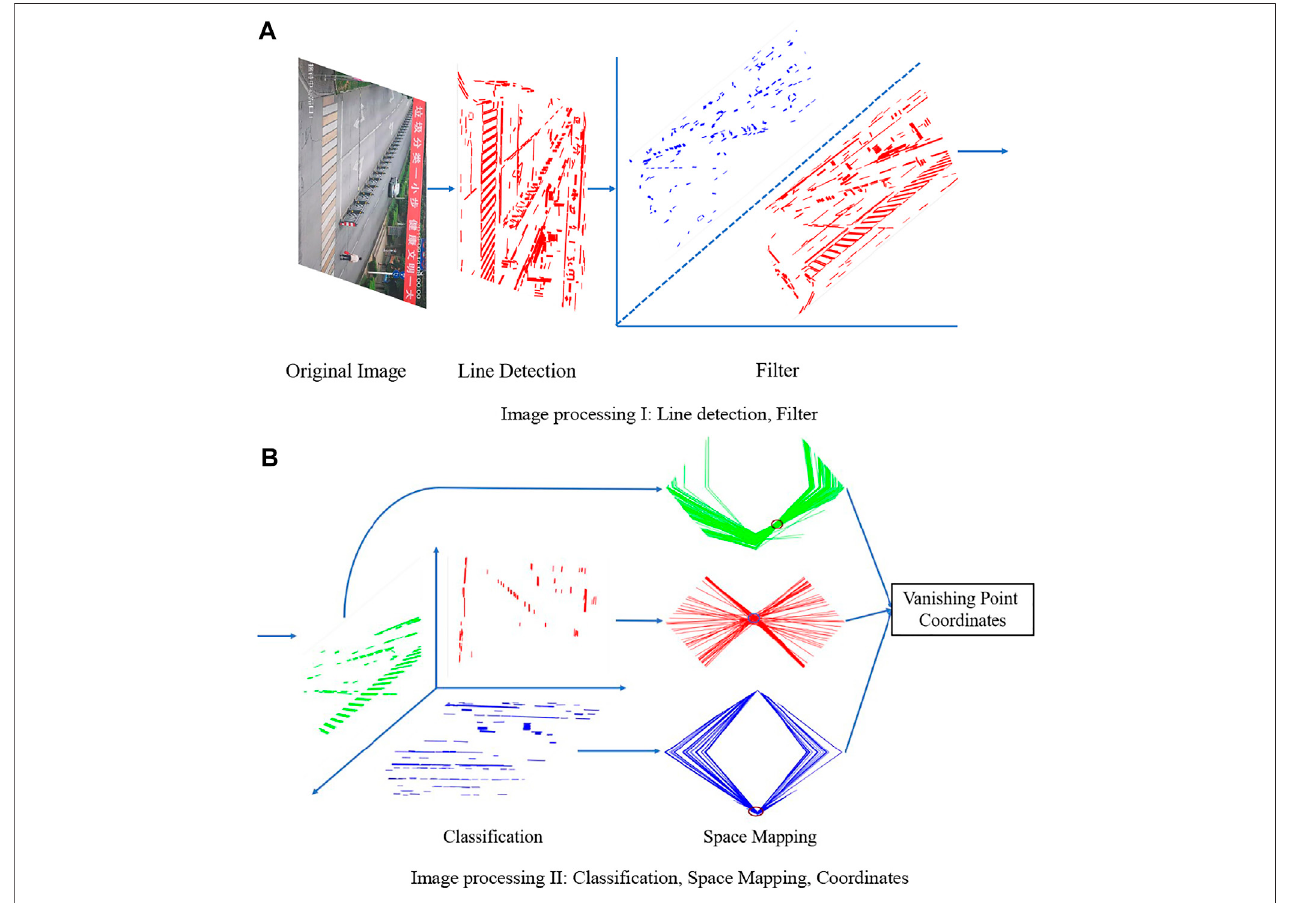
FIGURE1| Flowchartoftheproposedvanishing pointdetection method. (A) Image processingI:linedetection, fi lter. (B) Image processing II:classi fi cation, space mapping, coordinates.